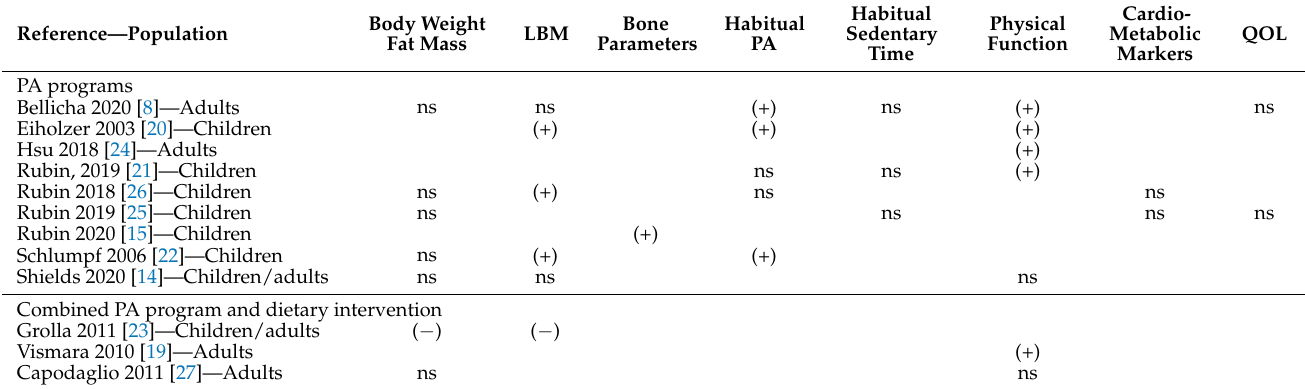
Table 3. Effects of PA interventions on different parameters of health